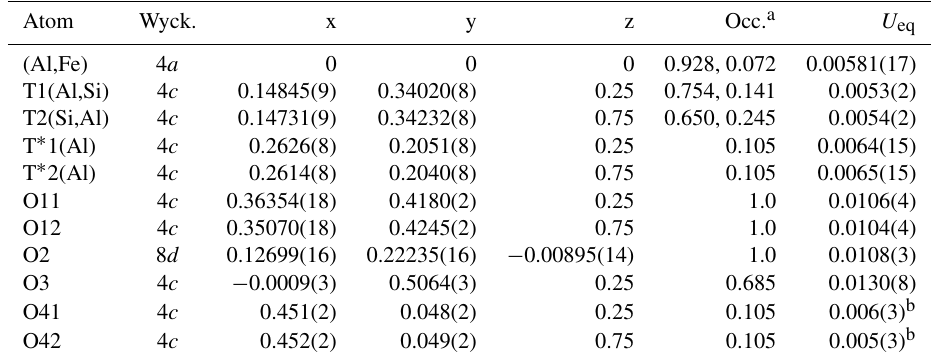
Table 3. Atomic coordinates, Wyckoff positions (Wyck.), site occupancies (Occ.) and equivalent isotropic displacement factors U eq (Å 2 ) for mullite-2 c . Atom Wyck. x y z Occ. a U eq (Al,Fe) 4 a 0 0